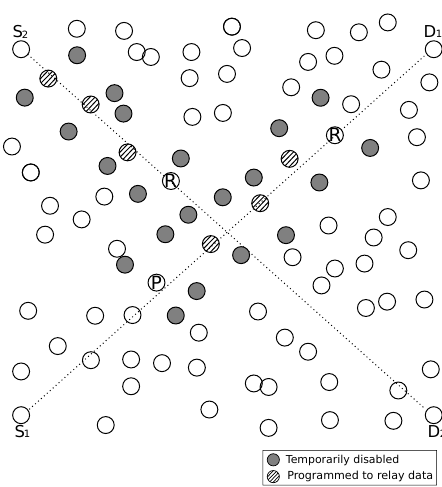
Figure 10. Simulation scenario with two concurrent data